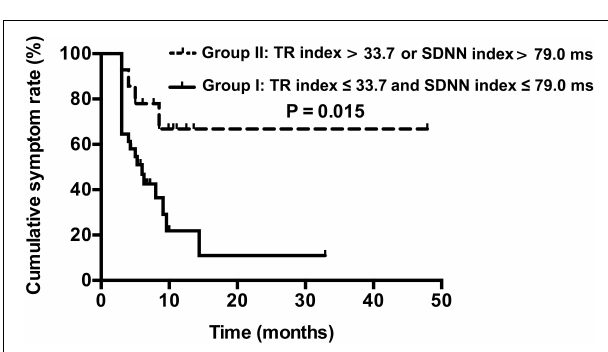
FIGURE 4 | Kaplan–Meier curve analysis of cumulative symptom rate between two groups of children with POTS. Group I: TR index ≤ 33.7 and SDNN index ≤ 79.0 ms, n = 31; Group II: TR index > 33.7 and SDNN index ≤ 79.0 ms, TR index ≤ 33.7 and SDNN index > 79.0 ms, or TR index > 33.7 and SDNN index > 79.0 ms, n =